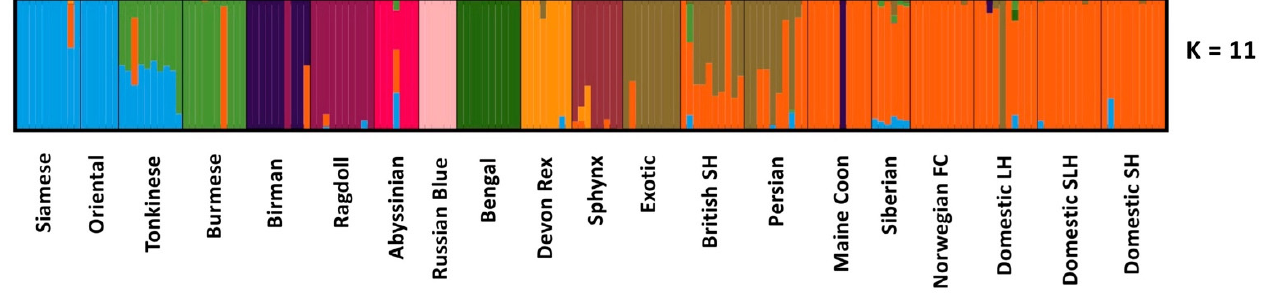
Figure 3. fastSTRUCTURE analysis of 840 DSH, DLH, and DSLH cats. At K = 2, 91% ( n = 772) random-bred cats had little evidence of admixture. Model complexity that maximized marginal likelihood was K = 2, and the model components used Figure 2. fastSTRUCTURE analysis on the balanced dataset. Each column represents an individual cat. Each cluster (K) is to explain structure in the data were K = 2. represented by a unique colour. The model component used to explain structure in the dataset ( K ∅ c) was K = 11.